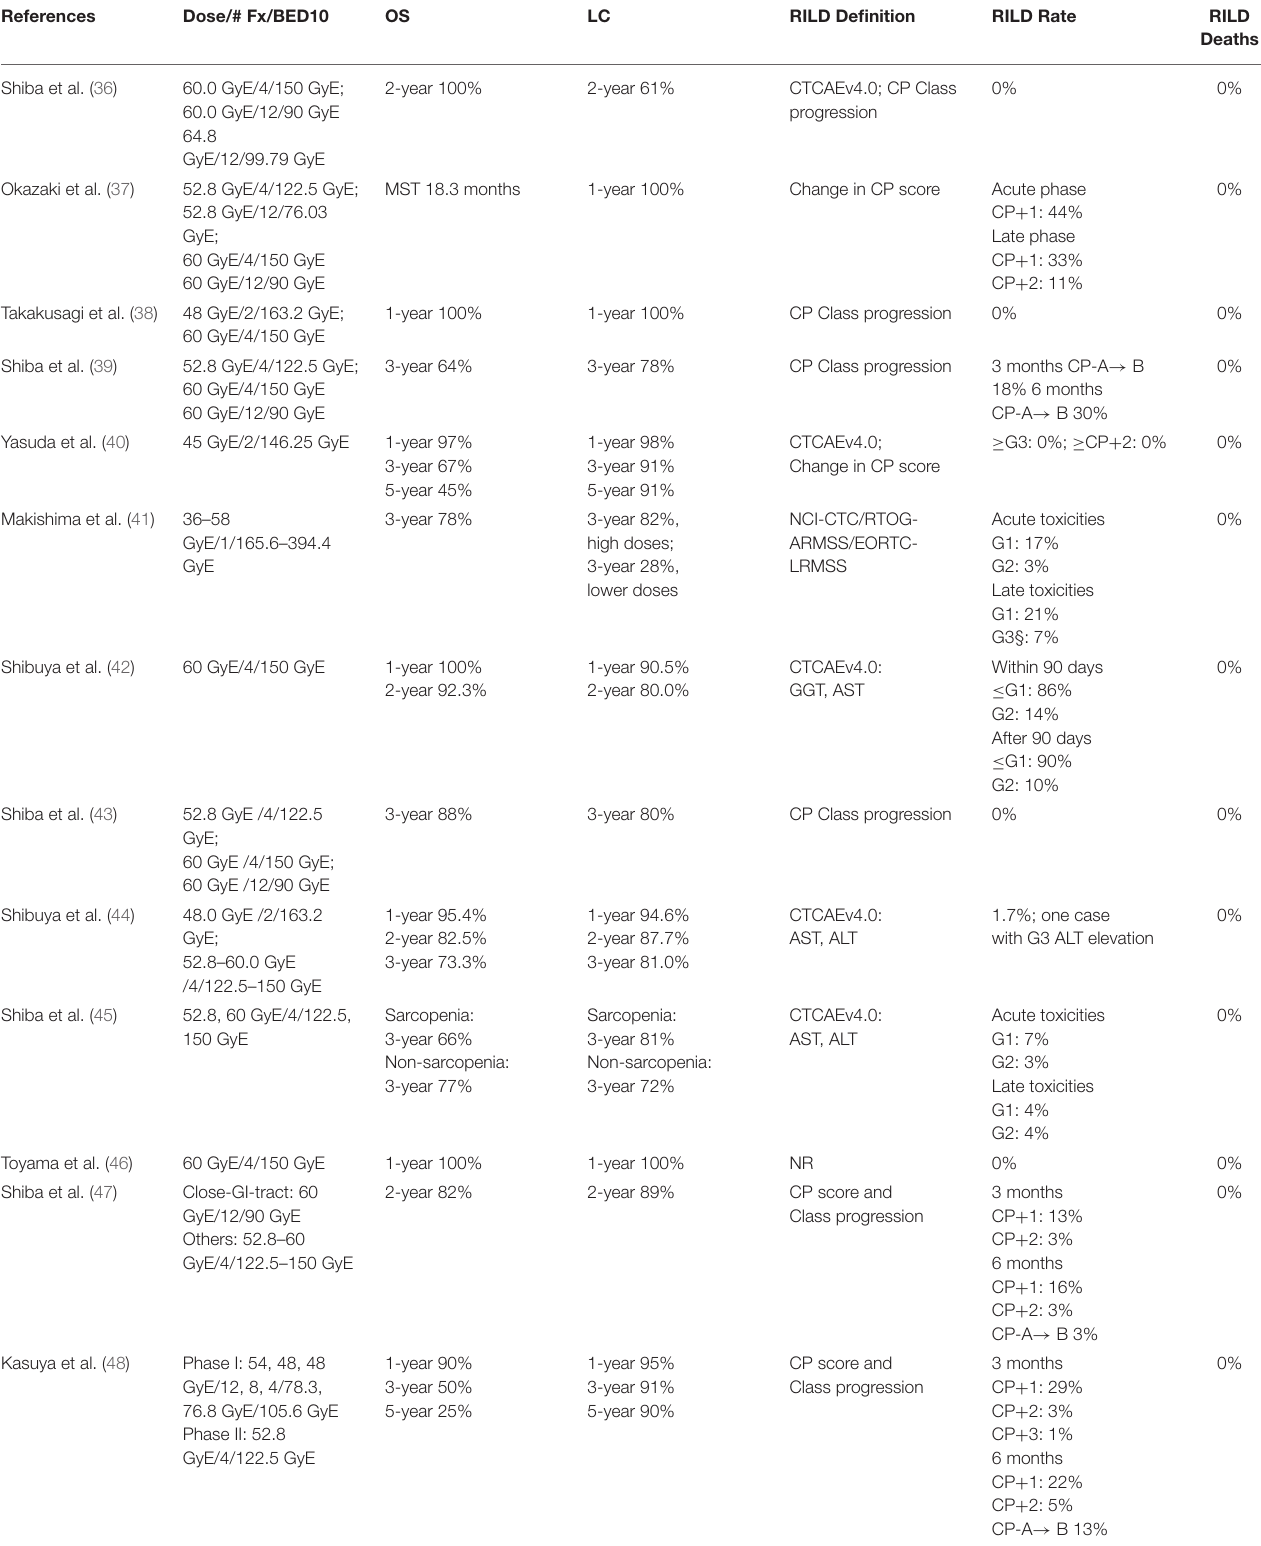
TABLE 2 | Clinical outcomes of the included CIRT studies for patients with liver